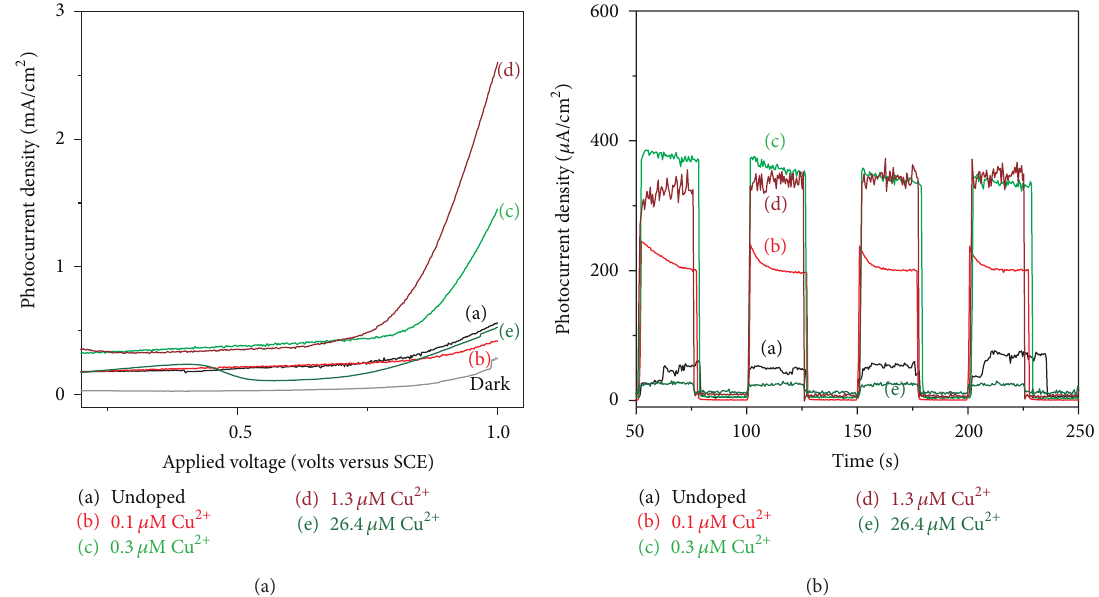
Figure 5: (a) Photocurrent potential curves under solar simulator (AM1.5G) for doped ZnO films with different doping concentrations. (b) Photocurrent transients of the same films at an applied bias voltage of 0.6V versus SCE under ON/OFF conditions.